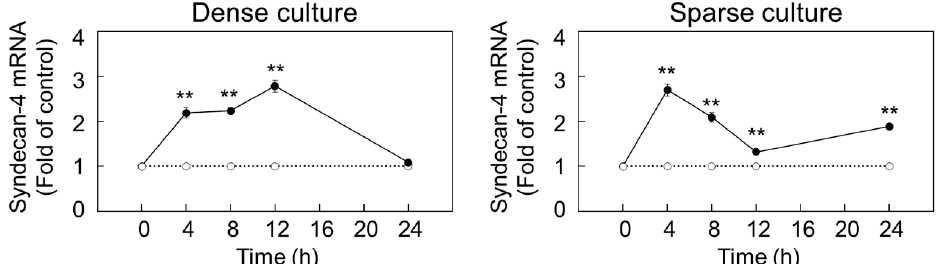
Figure 2. Time-dependent effects of FGF-2 on syndecan-4 mRNA expression in vascular endothelial cells. Dense and sparse cultures (left and right panels, respectively) of vascular endothelial cells were treated with (filled circle) or without (open circle) 20 ng/mL FGF-2 at 37 °C for 4, 8, 12, and 24 h and assessed for the transcript level of syndecan-4 by qRT-PCR. Values represent the mean ± S.E. of four technical replicates. ** p < 0.01, significantly different from the corresponding control.